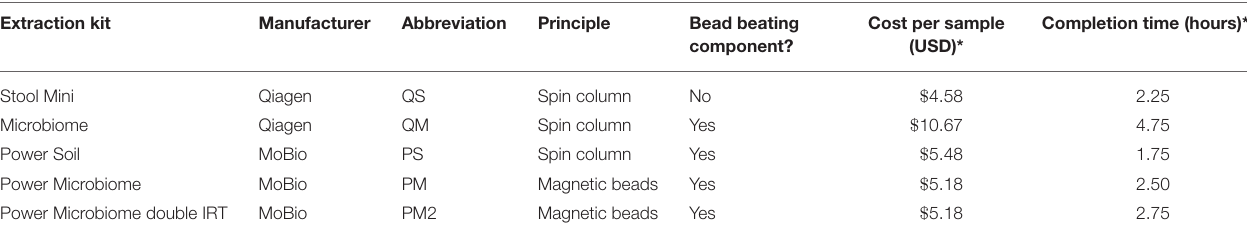
TABLE 1 | Summary of DNA extraction kit